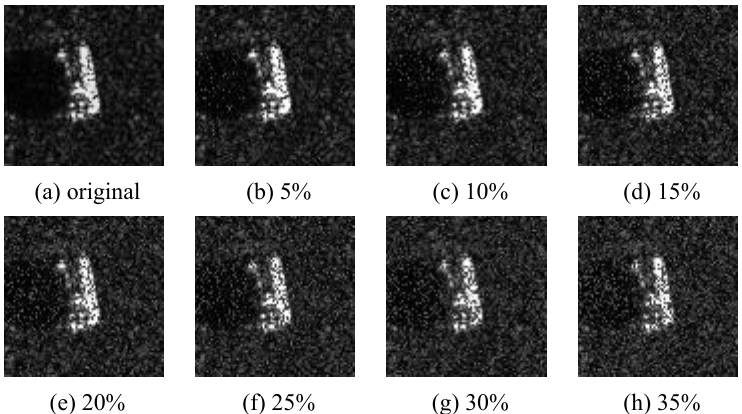
Figure 9. Examples of SAR images with different level of noise corruption.